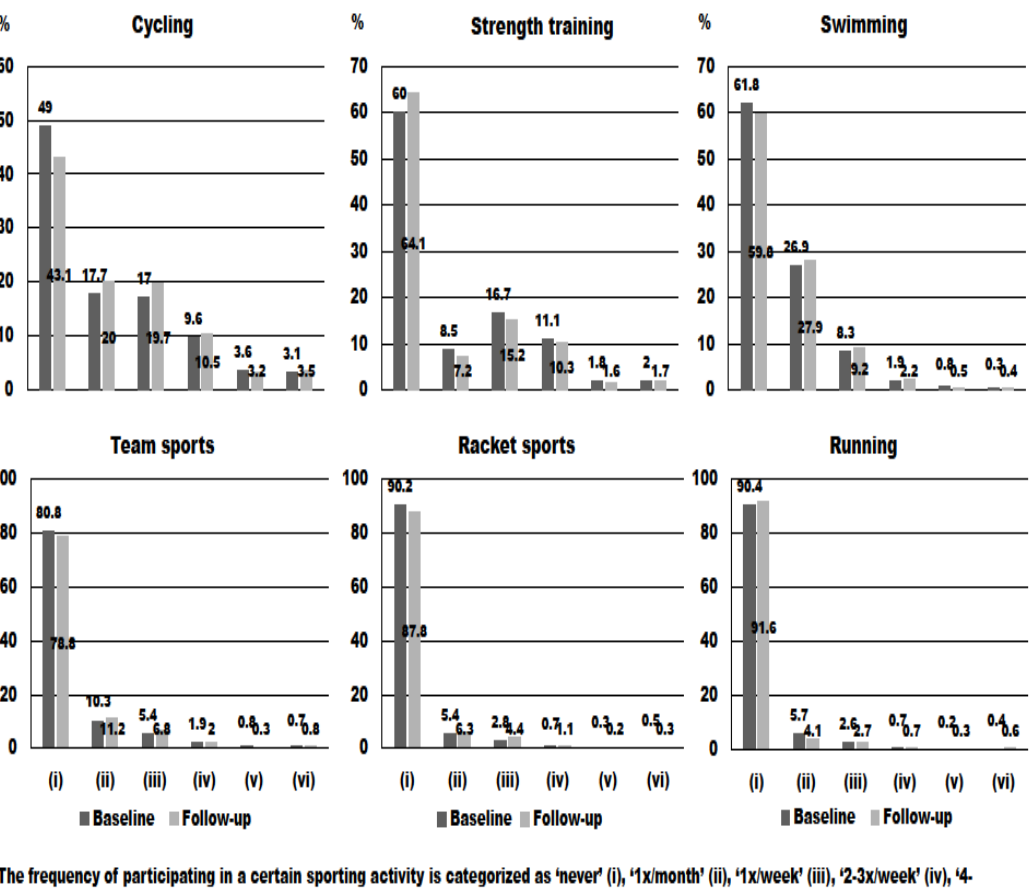
Figure 1. The frequency of participating in different sport-related activities at baseline and follow-up. The results for tracking coefficients of each sport activity are presented in Figure 2. Af- ter adjusting for maternal age, body mass index, education, self-rated health, and child’s gender, moderately high tracking coefficients were observed for cycling and strength train- ing, while swimming, team sports, racket sports, and running tracked moderately well over 11 years of follow-up. Of note is that the average weekly time spent in PA also showed a moderately high tracking characteristic ( β = 0.53, 95% 0.38–0.66). Tracking of participation in PA showed that mother who did not participate in PA at baseline were 81% more likely not to participate in PA at follow-up (OR = 1.81, 95% CI 1.53–2.13, p < 0.001). Note that those mothers who were active in a given sport at baseline were 2.10 times (OR = 2.10, 95% CI 1.76–2.52, p < 0.001) more likely to be physically active at follow-up.